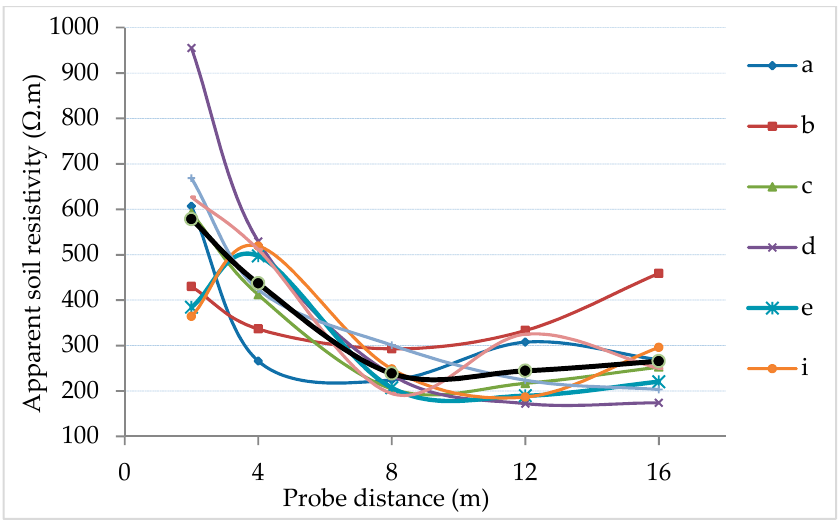
Figure 2. Soil resistivity variation versus probe distance for each measurement axis.